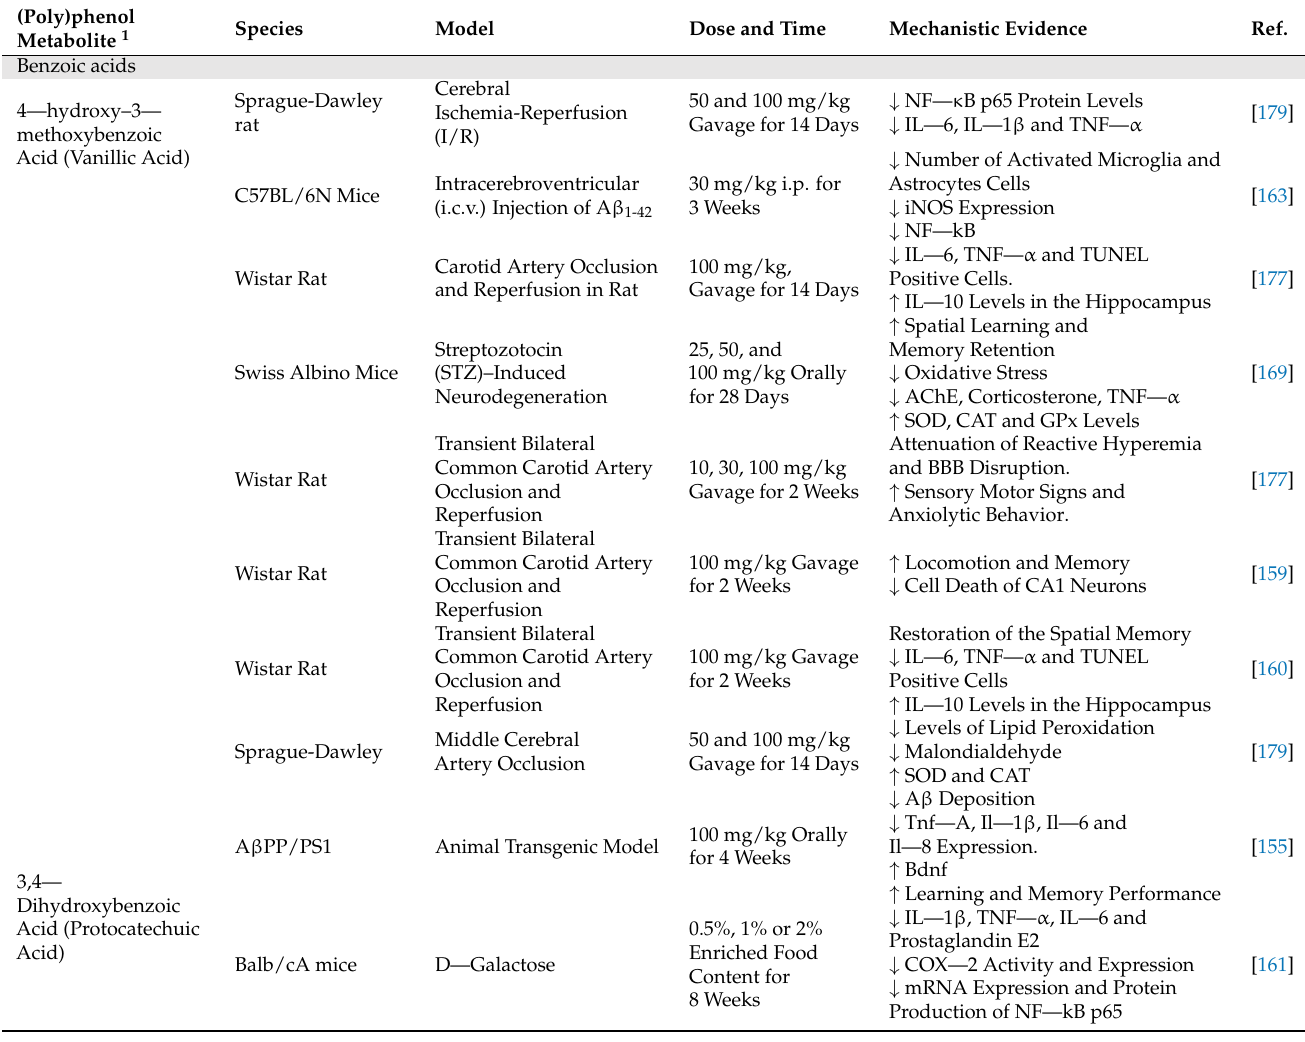
Table 7. Effects low molecular weight (poly)phenol metabolites in mice and rat models of